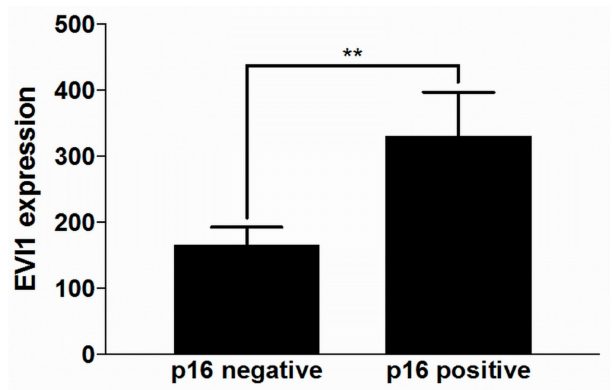
Figure 3. EVI1 expression in p16 positive and p16 negative HNSCC. The primary tumors were grouped by their p16 expression as p16 positive or negative. EVI1 expression in p16 positive primary tumors was significantly higher than in the p16 negative ones (unpaired t-test, statistically significant (** p < 0.01)).